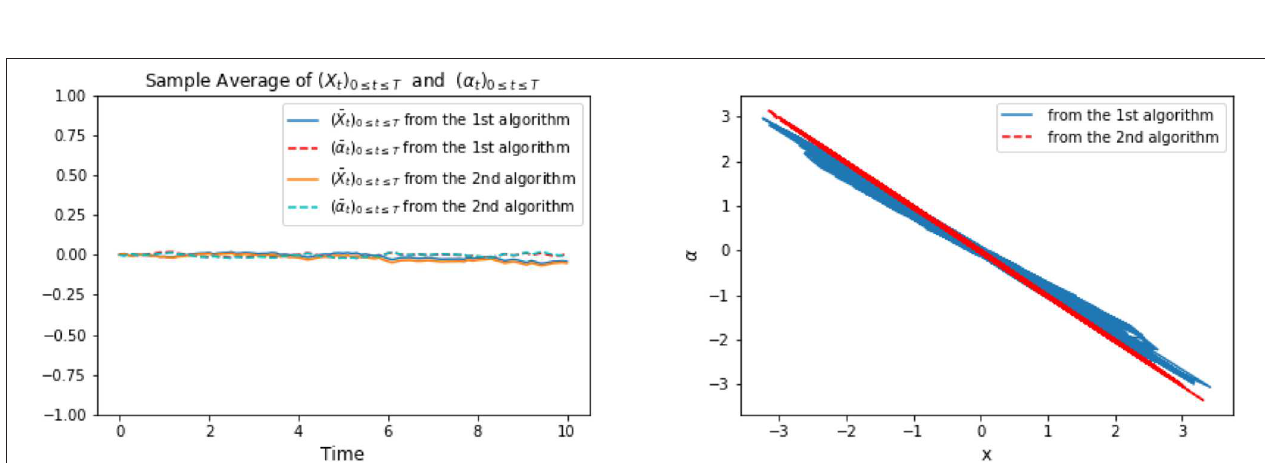
) t and ( α t ) t for both algorithm 1 and 2; The plot on the right shows the points of x i i 0 ≤ t i ≤ t N 0 ≤ t i ≤ t N